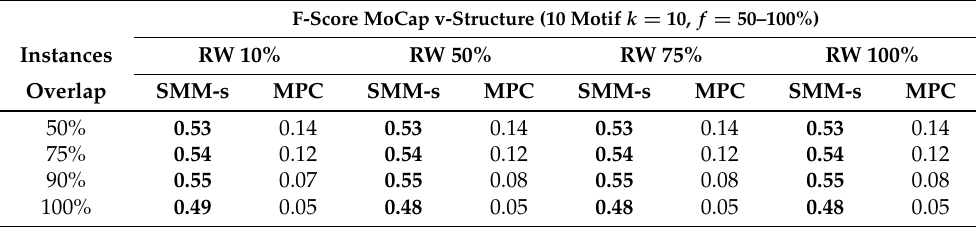
Table 7. F-scores for time series with 10 recurring patterns that are aligned from MoCap.